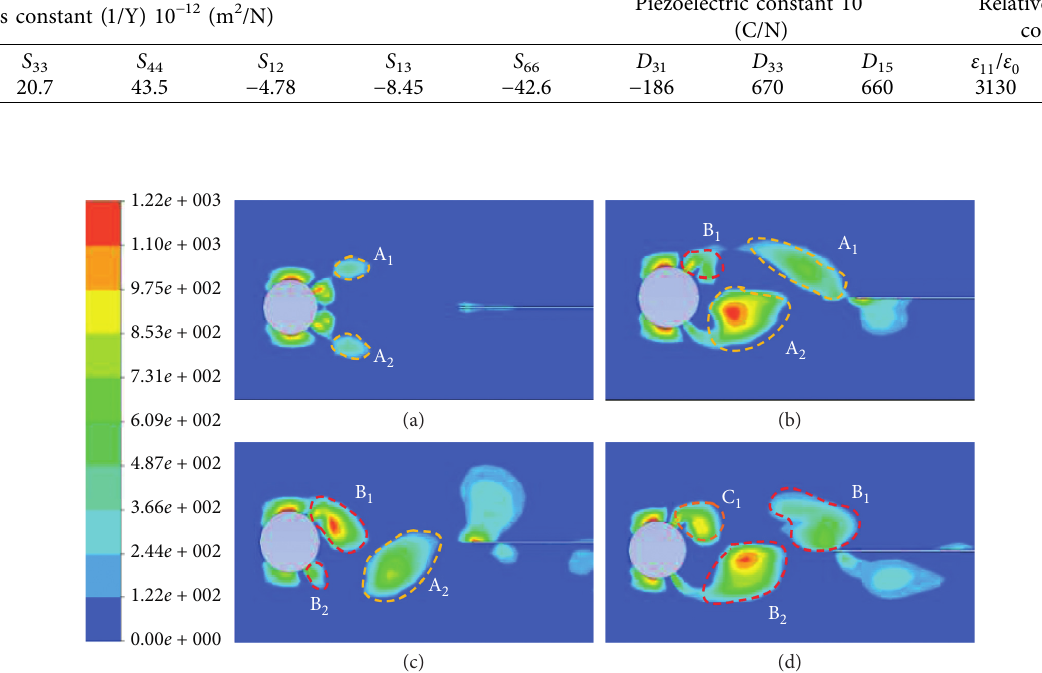
Figure 10: Vorticity cloud map of piezoelectric cantilever beam with vortex vibration. (a) t � 0.12s. (b) t � 0.24s. (c) t � 0.36s. (d) t �